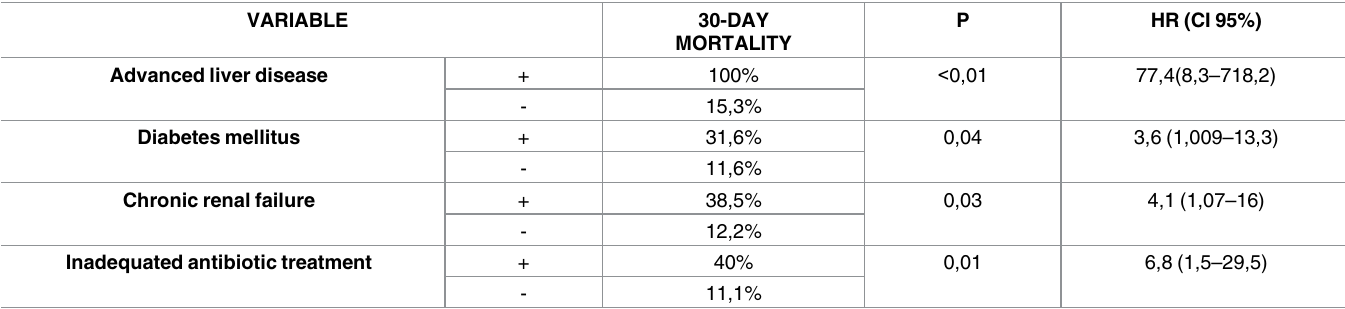
Table 3. Independent risk factors associated with mortality at 30 days (multivariate analysis made by Cox regression).